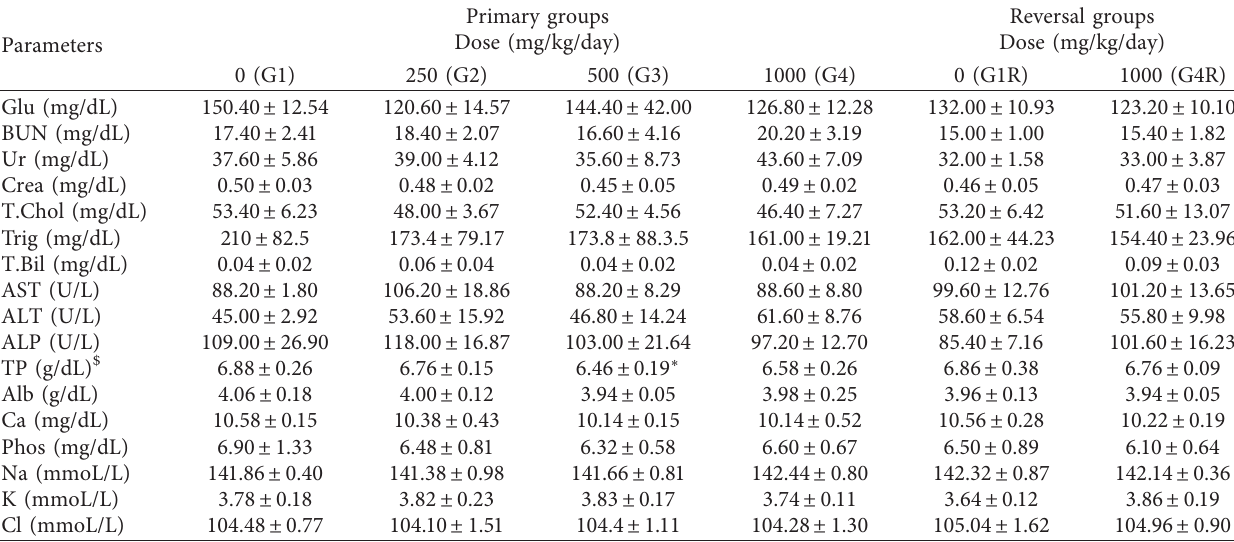
Table 9: Effect of oral administration of GMCT on biochemical parameters in male Wistar